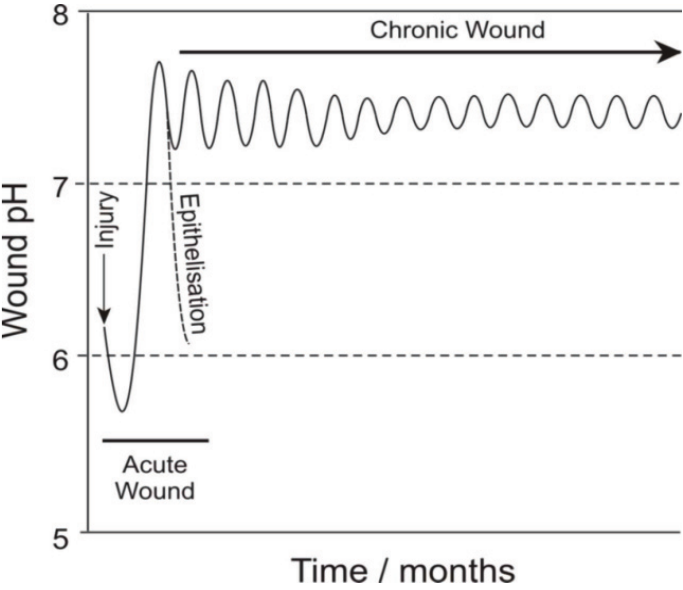
Figure 1. pH response dynamics for chronic and acute wounds. Adapted from Schneider et al. (2007)